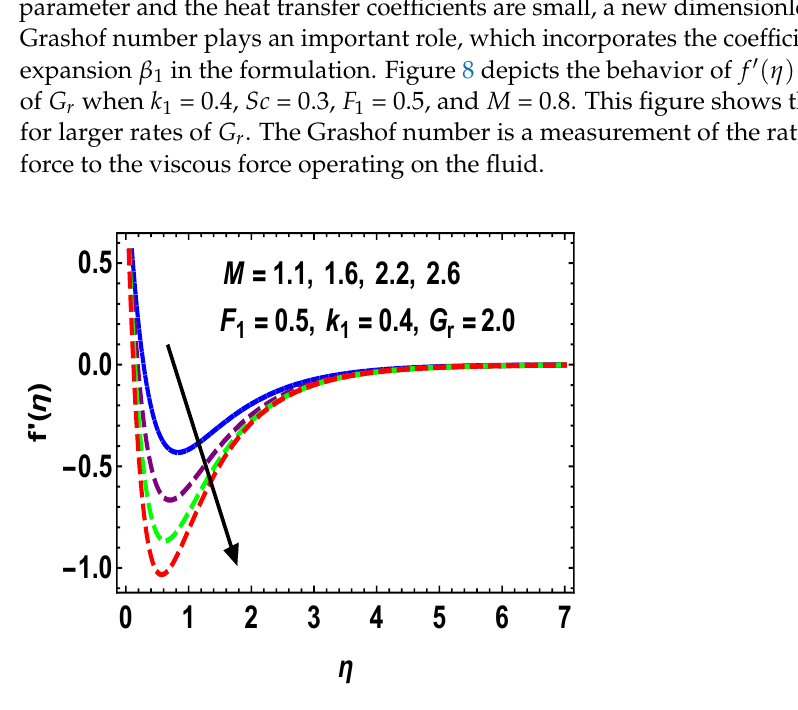
Figure 5. Outcomes of f (cid:48) ( η ) for M where blue, purple, green, and red lines represent for M = 1.1, M = 1.6, M = 2.2, and M = 2.6 respectively.